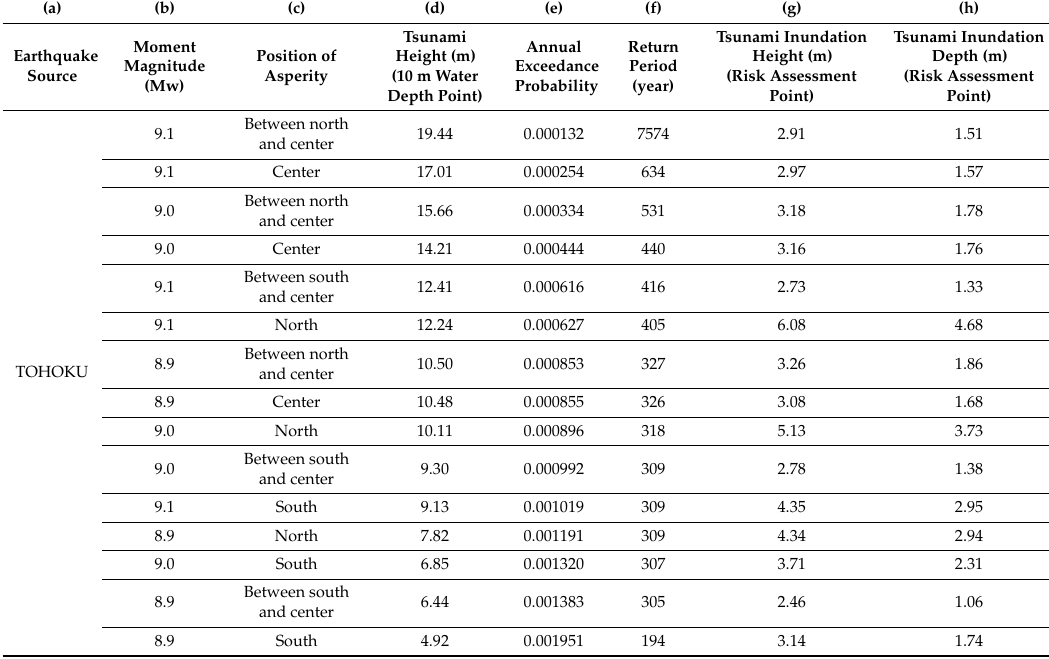
Table 8. Calculation results for Kesennuma. (a) Earthquake source name; (b) moment magnitude of the earthquake; (c) position of the asperity; (d) tsunami wave height at a water depth of 10 m; (e) annual exceedance probability estimated using the tsunami hazard curve; (f) return period calculated from the annual exceedance probability; (g) tsunami inundation height at the risk assessment point simulated using a nonlinear longwave equation with the fault